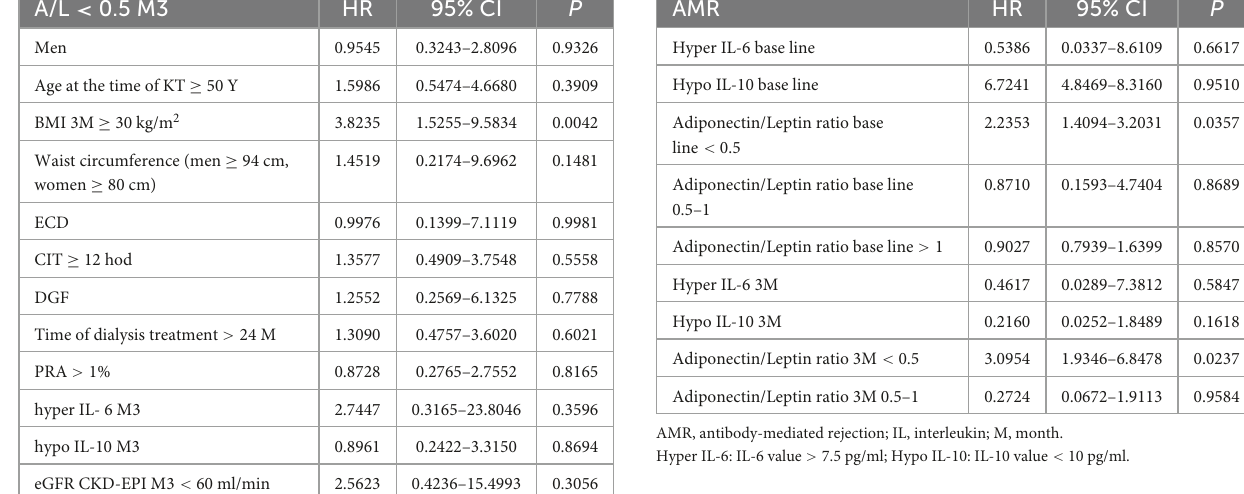
TABLE 8 Cox proportional hazard model, end point: acute cellular rejection in protocol graft